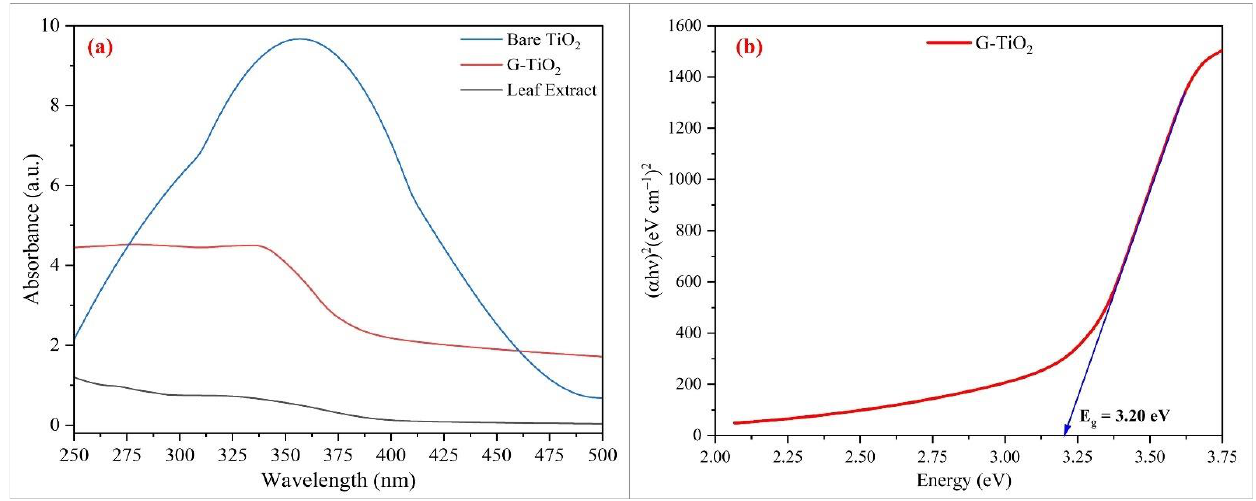
Figure 1. UV-visible spectra and tauc plot: ( a ) spectra of leaf extract, bare and biosynthesized TiO 2 nanoparticles; ( b ) tauc plot of biosynthesized TiO 2 nanoparticles.